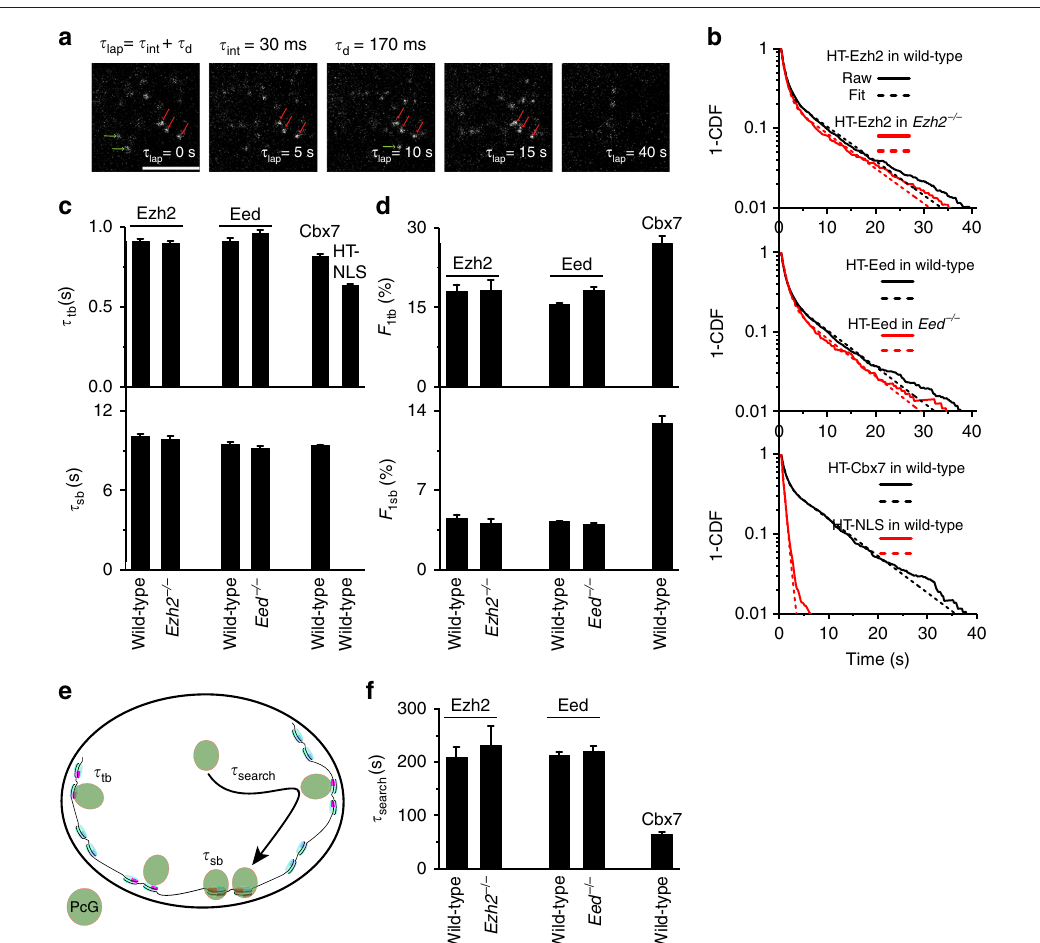
Fig. 1 PRC2 and Cbx7 exhibit distinct capacities for binding to chromatin. a Schematic illustrating HILO (highly inclined and laminated optical sheet). b Example image showing single HaloTag-Ezh2 molecules labeled with JF 549 dye during a 30 ms exposure time. The nucleus was marked by oval white dash circle. The individual white points represent single HaloTag-Ezh2 molecules. Scale bar, 2.0 µ m. c Displacement histograms for H2A-HaloTag ( N = 52 cells, n = 6172 displacements), HaloTag-NLS ( N = 66 cells, n = 6587 displacements), and HaloTag-Cbx7 ( N = 40 cells, n = 7725 displacements) in wild-type mES cells, for HaloTag-Ezh2 in wild-type ( N = 30 cells, n = 5532 displacements) and Ezh2 − / − ( N = 50 cells, n = 14,427 displacements) mES cells, and for HaloTag-Eed in wild-type ( N = 36 cells, n = 5444 displacements) and Eed − / − ( N = 77 cells, n = 8845 displacements) mES cells. The short dash red curve indicates the overall fi t. NLS, nuclear localization sequence. HT, HaloTag. d Cumulative distribution of displacements for H2A-HaloTag, HaloTag-NLS, and HaloTag-Cbx7 in wild-type mES cells, for HaloTag-Ezh2 in wild-type and Ezh2 − / − mES cells, and for HaloTag-Eed in wild-type and Eed − / − mES cells. The cumulative distributions were fi tted with two or three components. Fitted parameters are shown in Supplementary Table 1. Unless otherwise indicated, the reported kinetic fractions and diffusion constants were obtained from the cumulative distributions. Solid curve represents raw data. Short dash curve is fi tted data. e Fraction of the chromatin-bound population ( F 1 ) obtained from d . Results are means ± SD from three biological replicates. f Immunostaining of H3K27me3 in wild-type, Ezh2 ─ / ─ , Eed ─ / ─ , HaloTag-Ezh2 / Ezh2 ─ / ─ , and HaloTag-Eed / Eed ─ / ─ mES cells by using antibody directed against H3K27me3 (green). DNA was stained with hoechst (red). Overlay images are shown. The residual H3K27me3 level was detectable in Ezh2 ─ / ─ mES cells because of the presence of Ezh1. Scale bar, 5.0 µ